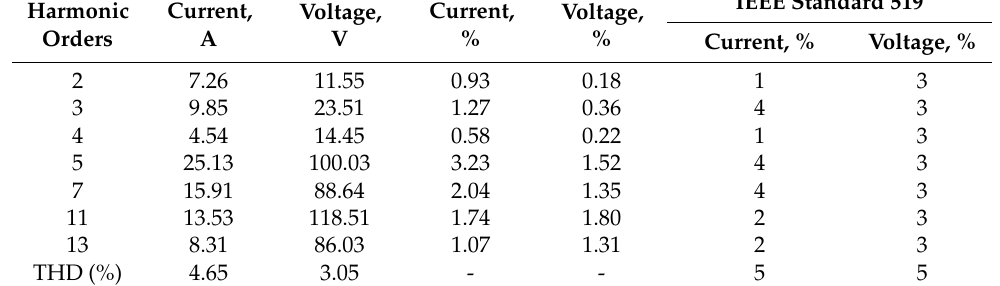
Table 8. Harmonic distortion of the design solution obtained by the proposed TLBO-based method.